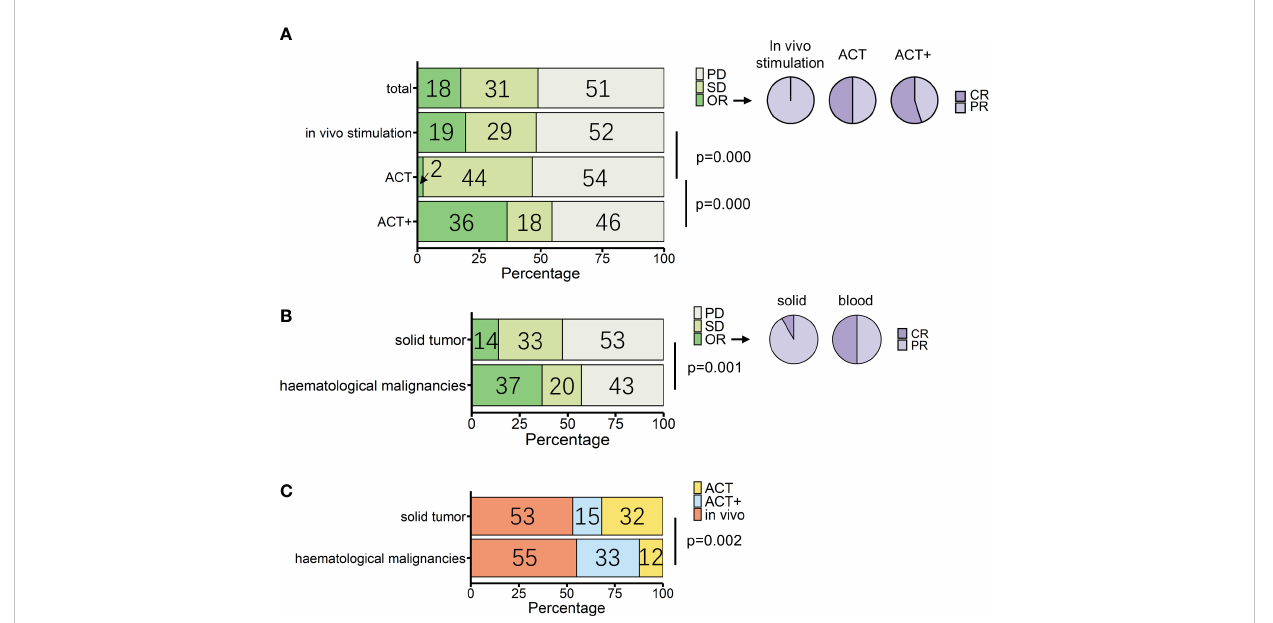
FIGURE 3 Overview of patients treated with gd T-cell immunotherapy ( n = 307). (A) Proportions of treatment outcomes in total measurable patients and different treatment types [ in vivo stimulation, n = 164; adoptive cell transfer (ACT), n = 88; ACT combined with other treatments except for IL-2 treatment (ACT+), n = 55]. Pie charts show the proportions of complete response (CR) and partial response (PR) within objective response (OR) patients for each treatment method ( in vivo stimulation, n = 32; ACT, n = 2; ACT+, n = 20). (B) Proportions of treatment outcomes in different types of tumors (solid, n = 258; hematological, n = 49). Pie charts show the proportions of CR and PR within OR patients for each tumor type (solid, n = 36; hematological, n = 18). (C) Proportions of treatment types applied in different types of tumors (solid, n = 258; hematological, n = 49). p - values (Pearson ’ s chi-squared test) are indicated in (A – C) . PD, progressive disease; SD, stable disease; OR, objective response; CR, complete response; PR, partial